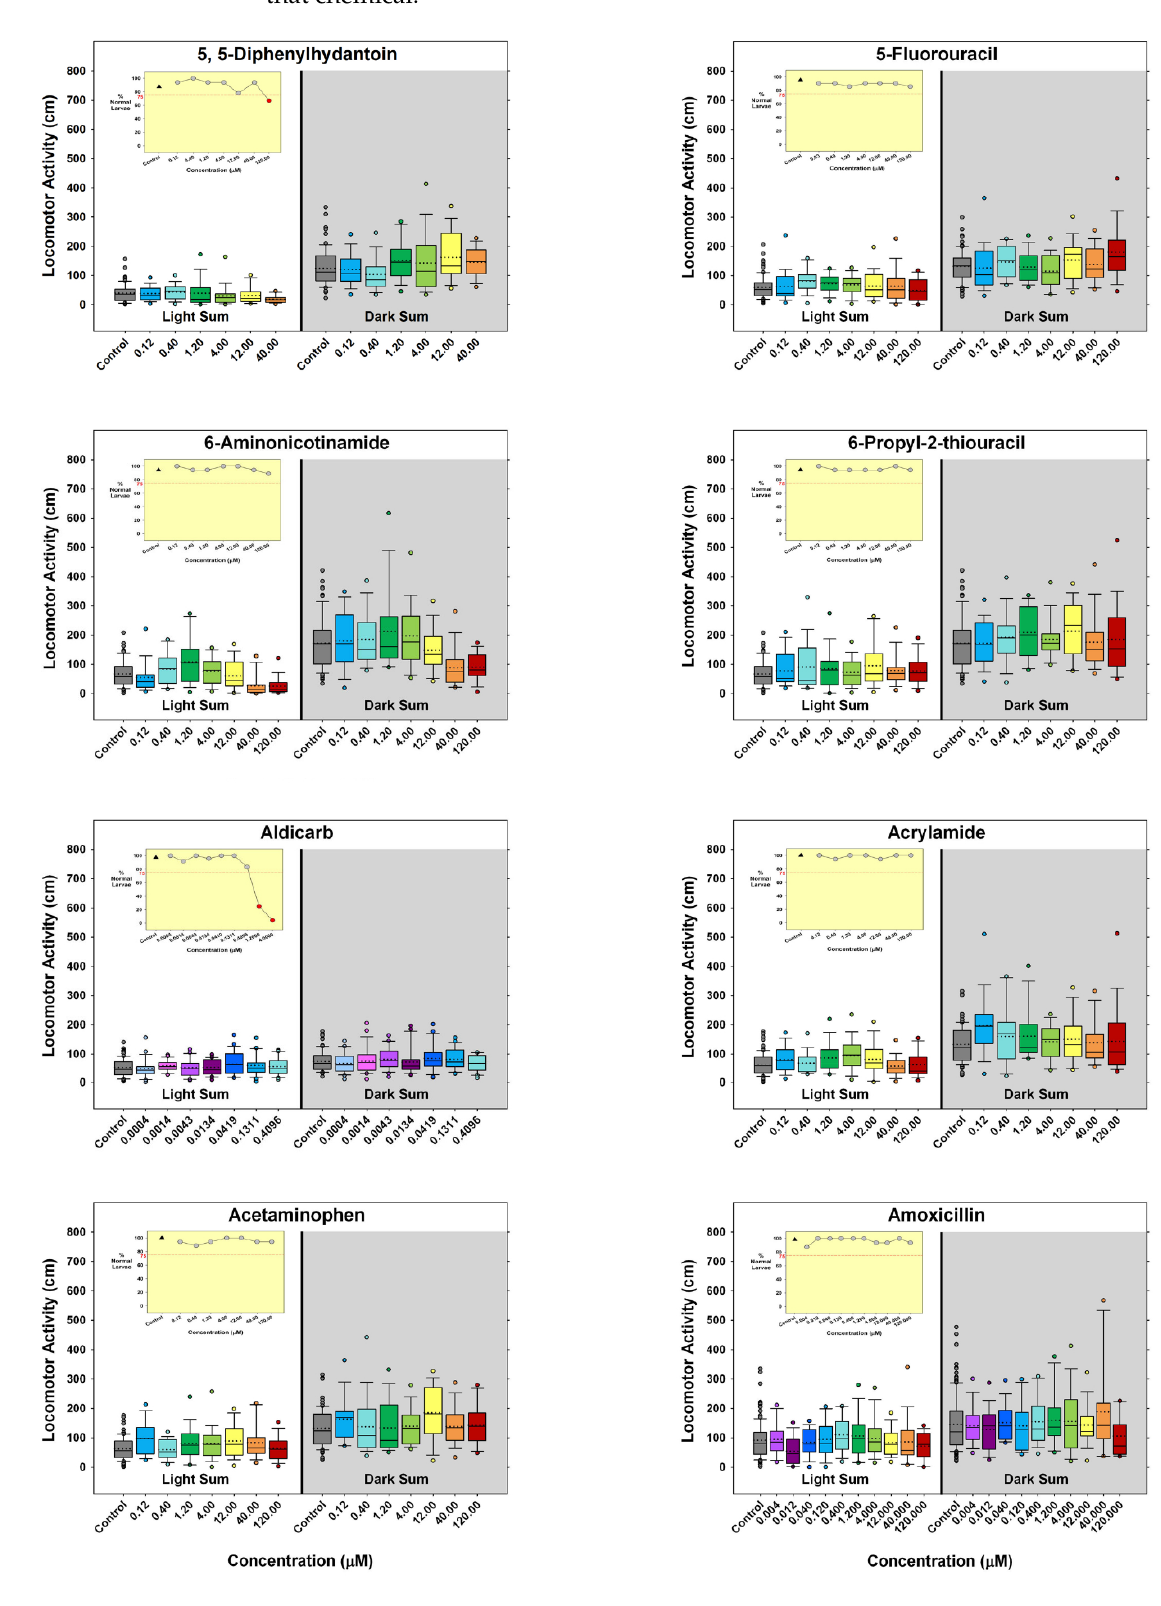
that line indicated by a red circle. The black triangle represents negative control data for that chemical.